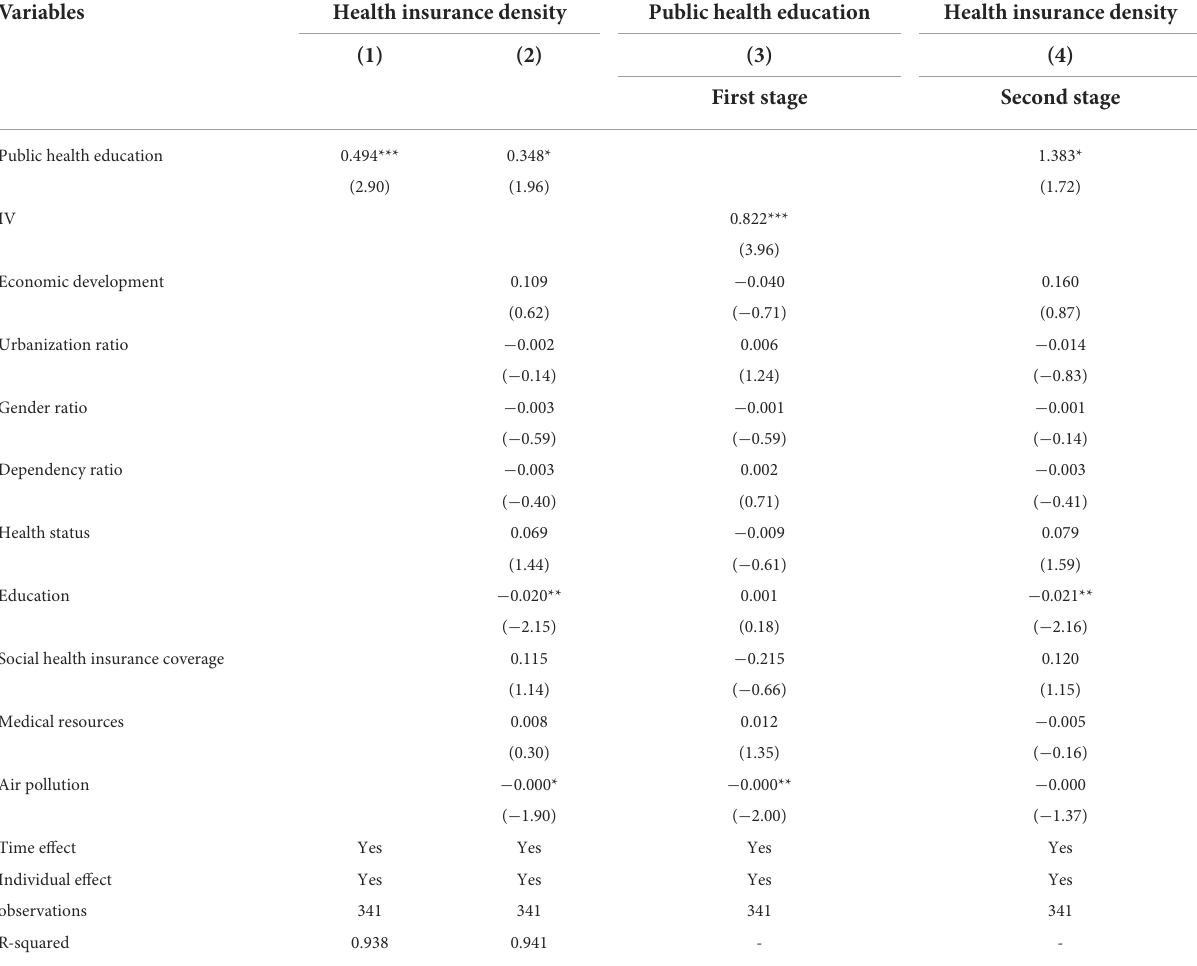
TABLE 3 The impact of public health education on the demand for commercial health